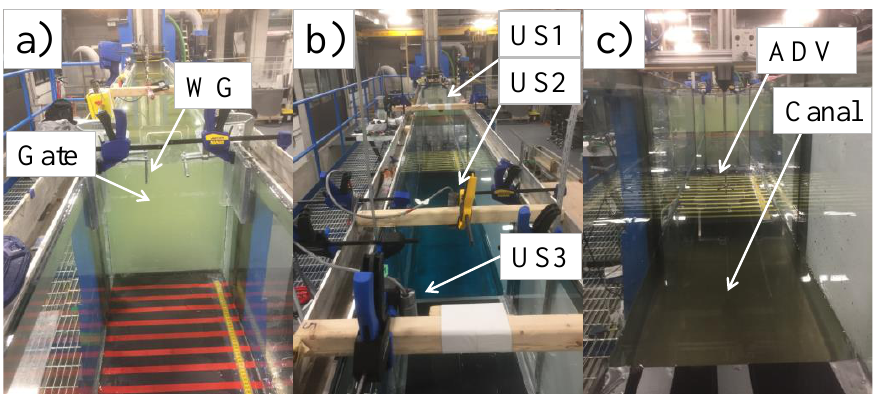
Figure 2. Schematic of experimental setup and coordinate system: ( a ) side view; ( b ) top view (not at scale).